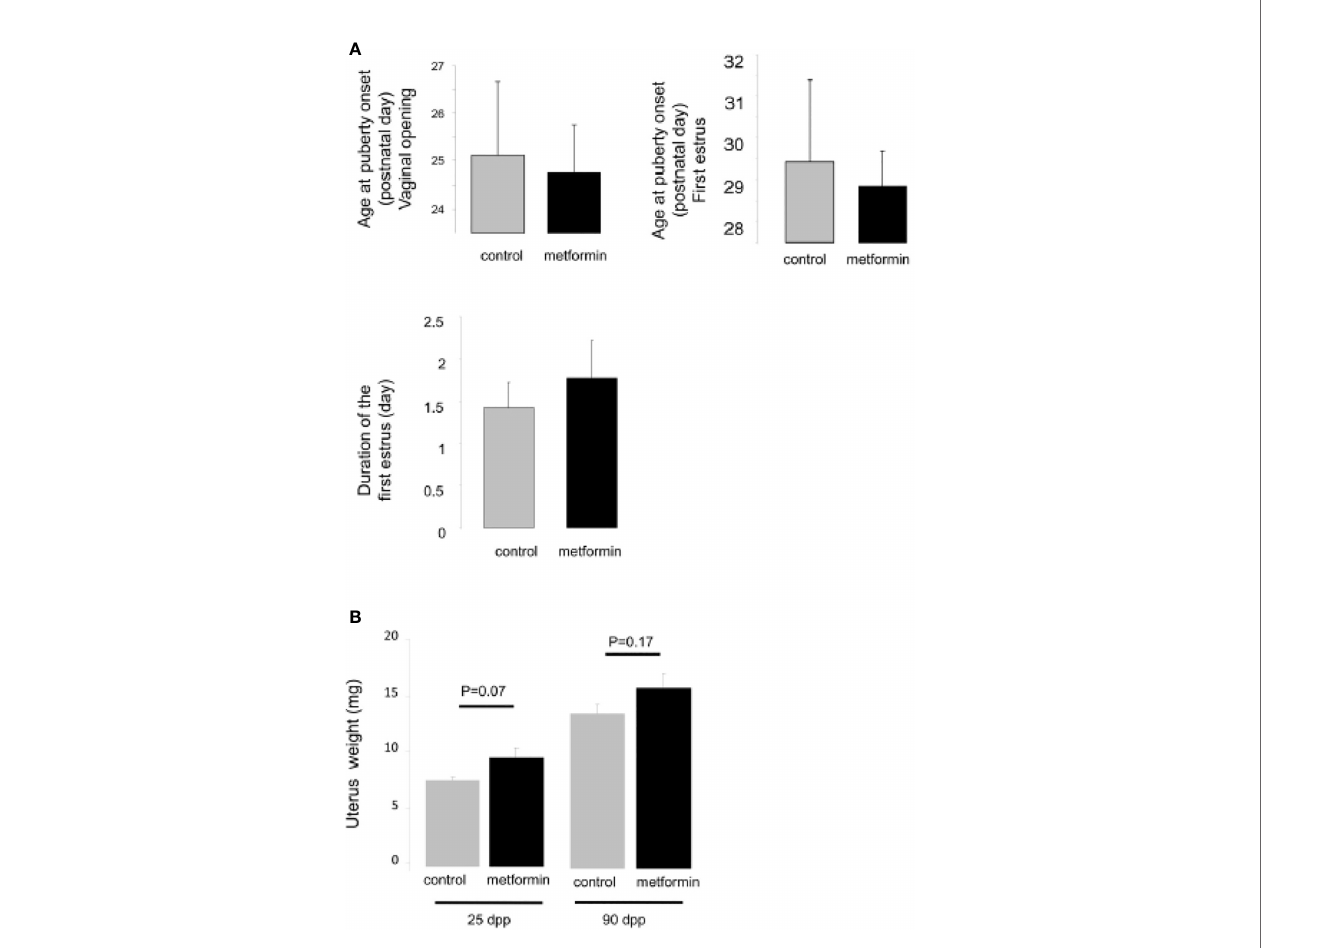
FIGURE 6 | Age of puberty of female exposed in utero to metformin. (A) Age at vaginal opening (postnatal day), age at fi rst ovulation (postnatal day), duration of the fi rst estrus (day). (B) The weight of the uterus, a sensitive estrogenic tissue, from female mice exposed to metformin in utero at 25 dpp and 90